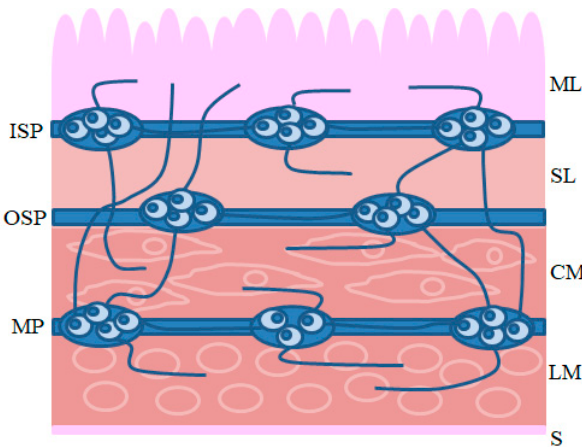
Figure 1. The enteric nervous system in the porcine intestine: MP, myenteric plexus; OSP, outer submucous plexus; ISP, inner submucous plexus. Structural parts of the intestinal wall: S, serosa; LM, longitudinal muscle layer; CM, circular muscle layer; SL, submucosal layer; ML, mucosal layer. CGRP is a 37-amino acid neuropeptide belonging to the calcitonin (CT) family of peptides and